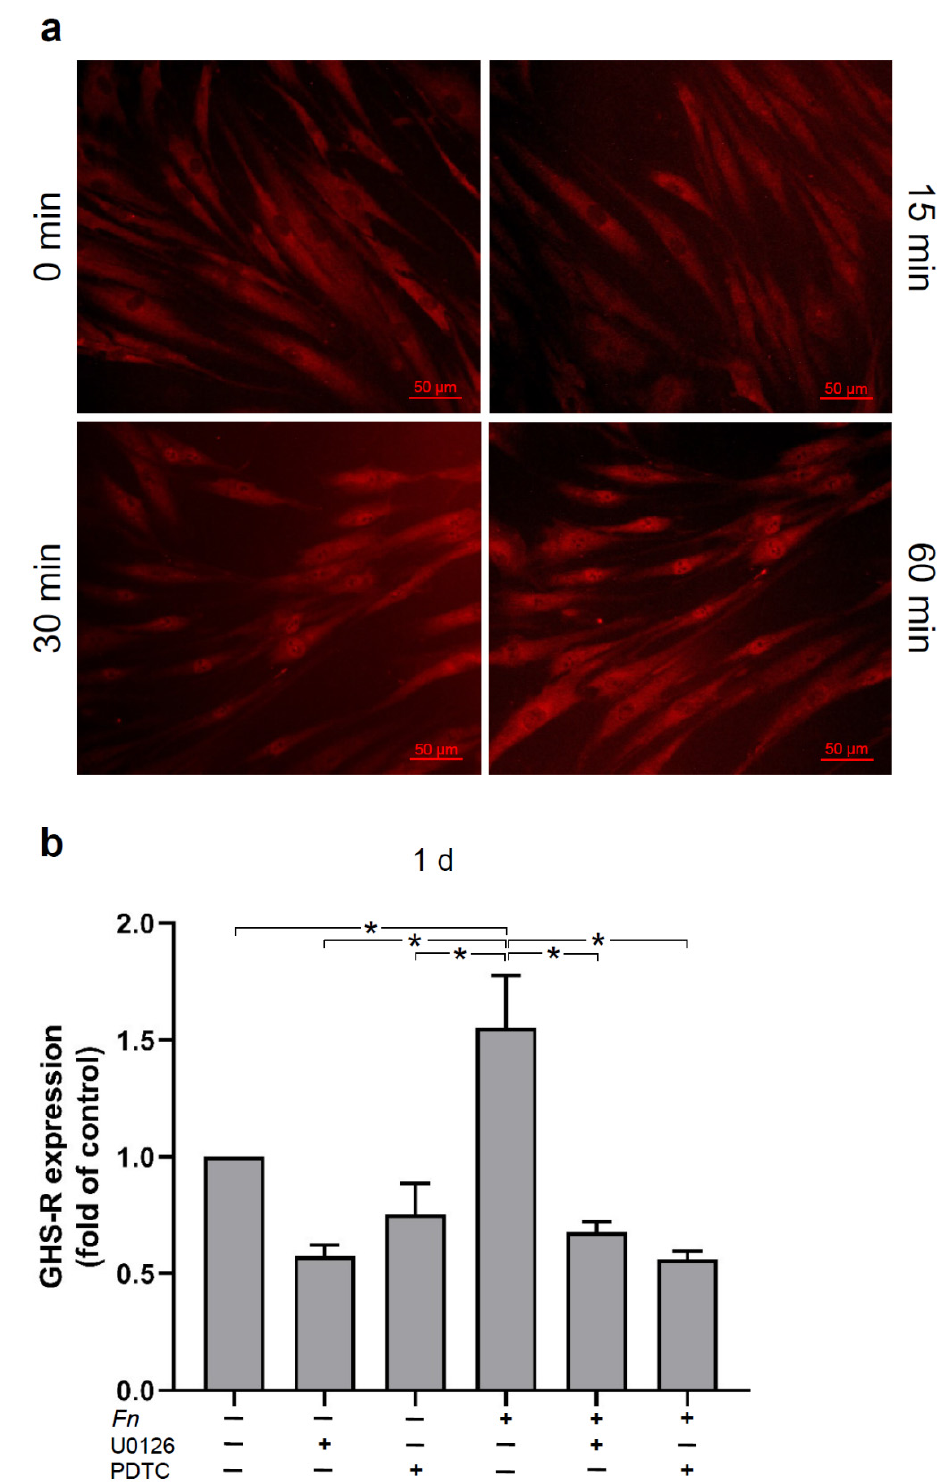
Figure 3. ( a ) Stimulation of NF- κ B (p65) nuclear translocation by F. nucleatum ( Fn ATCC 25586, OD 660 : 0.1) in HGF cells over time, as evaluated by immunofluorescence. Images are from one representative donor. ( b ) Stimulation of GHS-R expression in the presence (+) and absence ( − ) of F. nucleatum ( Fn ATCC 25586, OD 660 : 0.1) in the presence (+) and absence ( − ) of U0126, a MEK1/2 inhibitor (10 µ M) or PDTC, a NF- κ B inhibitor (10 µ M), in HGF cells at 1 d, as analyzed by real-time PCR. Mean ± SEM (n = 6). * Significant ( p < 0.05) difference between groups. Unstimulated cells served as